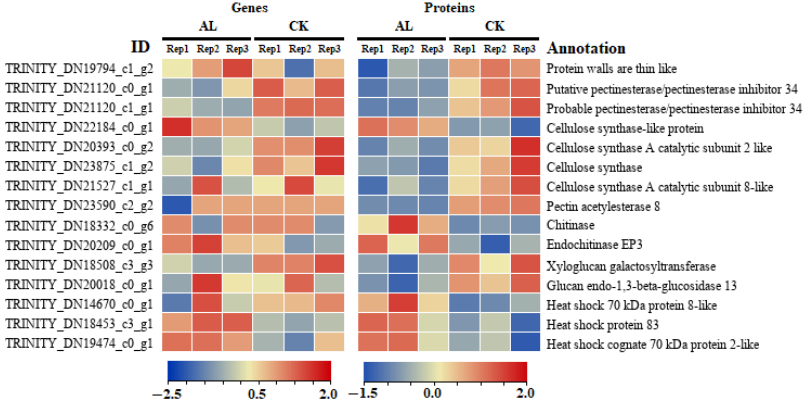
Figure 4. Heat-map analyses of the differentially expressed proteins related to cell wall synthesis.